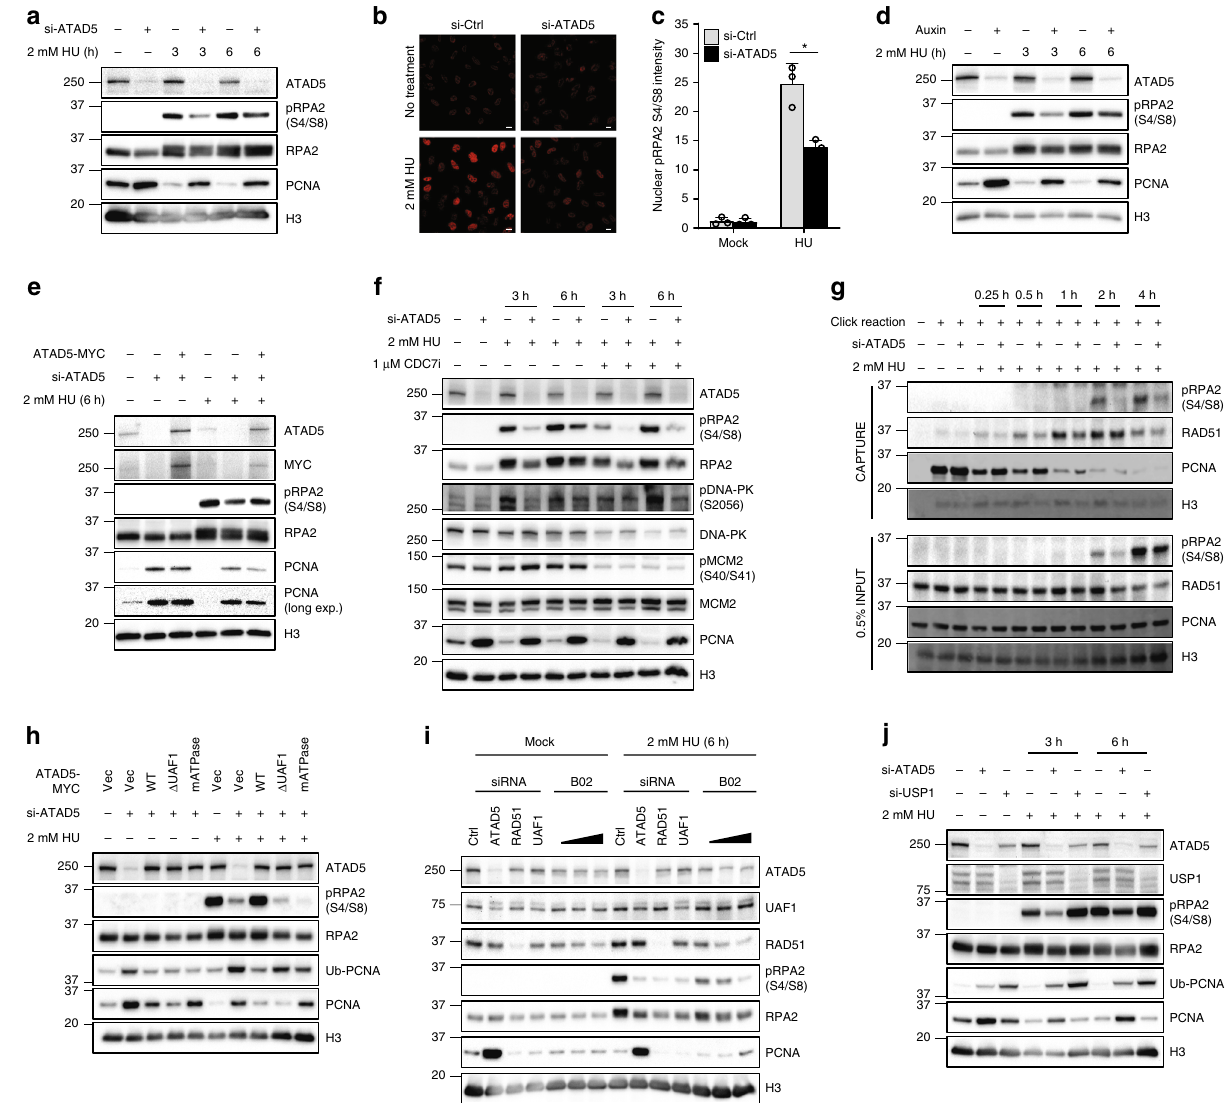
Fig. 4 ATAD5 promotes generation of single-stranded DNA-associated breaks in response to replication stress. a U2OS cells transfected with ATAD5 siRNA under the Noco-APH condition were treated with 2 mM HU for 3 or 6 h. Then, chromatin-bound proteins were fractionated and subjected for immunoblotting. b , c U2OS cells transfected with ATAD5 siRNA under the Noco-APH condition were treated with 2 mM HU for 3 h before fi xation. The fi xed cells were stained with an anti-pRPA2 S4/S8 antibody. b Representative images of chromatin-bound pRPA2 S4/S8. Scale bar: 20 μ m. c The intensity of chromatin-bound pRPA2 S4/S8 staining was quanti fi ed from ~20,000 cells. Error bars represent standard deviation of the mean ( n = 3). Statistical analysis: t test; * p < 0.05. d U2OS cells expressing ATAD5 AID were pre-treated with auxin and treated with 2 mM HU for 3 or 6 h. Chromatin-bound proteins were separated by SDS-PAGE and subjected for immunoblotting with indicated antibodies. e U2OS cells transfected with a combination of ATAD5 siRNA and a DNA vector expressing ATAD5-myc under the Noco-APH condition were treated with 2 mM HU for 6 h. Then, chromatin-bound proteins were fractionated and subjected for immunoblotting. f U2OS cells transfected with ATAD5 siRNA under the Noco-APH condition were treated with 2 mM HU or 1 μ M CDC7 inhibitor (CDC7i, PHA-76941) for the indicated times. Then, chromatin-bound proteins were fractionated and subjected for immunoblotting. g HEK293T cells transfected with ATAD5 siRNA for 48 h were labeled with 10 μ M EdU for 20 min prior to treatment with 2 mM HU as indicated. Samples were processed for iPOND, and captured proteins were separated by SDS-PAGE and immunoblotted. h U2OS-TetOn-ATAD5 cells treated with doxycyclinfor 24 h before entering the Noco-APH condition were treated with 2 mM HU for 6 h. Chromatin-bound proteins were fractionated and subjected for immunoblotting. i , j U2OS cells transfected with siRNAs or treated with a RAD51 inhibitor (B02, 10, 20, 40 μ M) at the time of release from aphidicolin under the Noco-APH condition were treated with 2 mM HU as indicated. Chromatin-bound proteins were fractionated and subjected for lagging strand could be inhibited by remaining PCNA on the PCNA removal and RPA protein loading at DNA damage sites 29 . lagging strand. Another possibility is that PCNA itself might Similarly, it is possible that when ATAD5 is depleted, PCNA prevent the reannealing of single-stranded DNA at the beginning accumulated on the lagging strand at the replication forks might of fork regression. The reannealing of nascent DNA to generate a prevent the RAD51 fi lament from ef fi ciently forming on the chicken foot-shaped four-way structure could also be affected by lagging strand. Otherwise, strand invasion by the RAD51 fi lament the remaining PCNA. The results of single-molecule experiments formed on the leading strand into homologous DNA on the